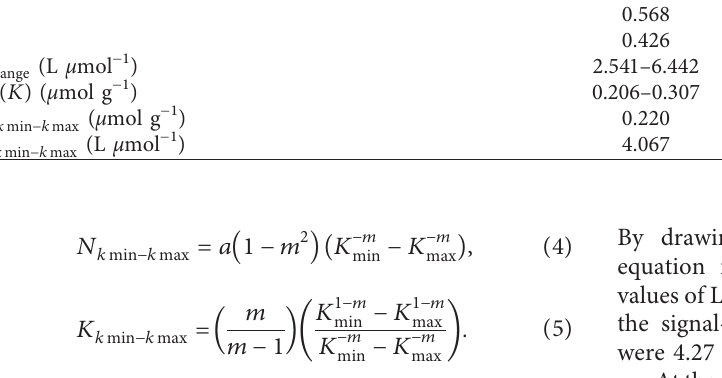
Figure 6: (a) CLB adsorption isotherms for MMIPs and MNIPs with the corresponding experimental FI for MMIPs and MNIPs; (b) affinity distributions of MMIPs (black curve) and MNIPs (red curve). Table 1: Characteristic parameters of the Freundlich isothermal equation. Fitting